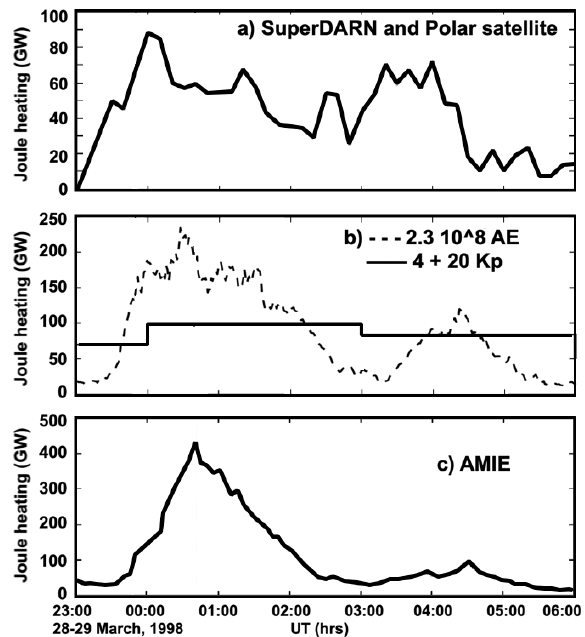
Figure 2. Discrepancies between global integrated Joule heating as estimated by (a) SuperDARN and Polar measurements, (b) AE- and Kp-based proxies, and (c) the AMIE procedure during a solar storm (adapted from Palmroth et al.,